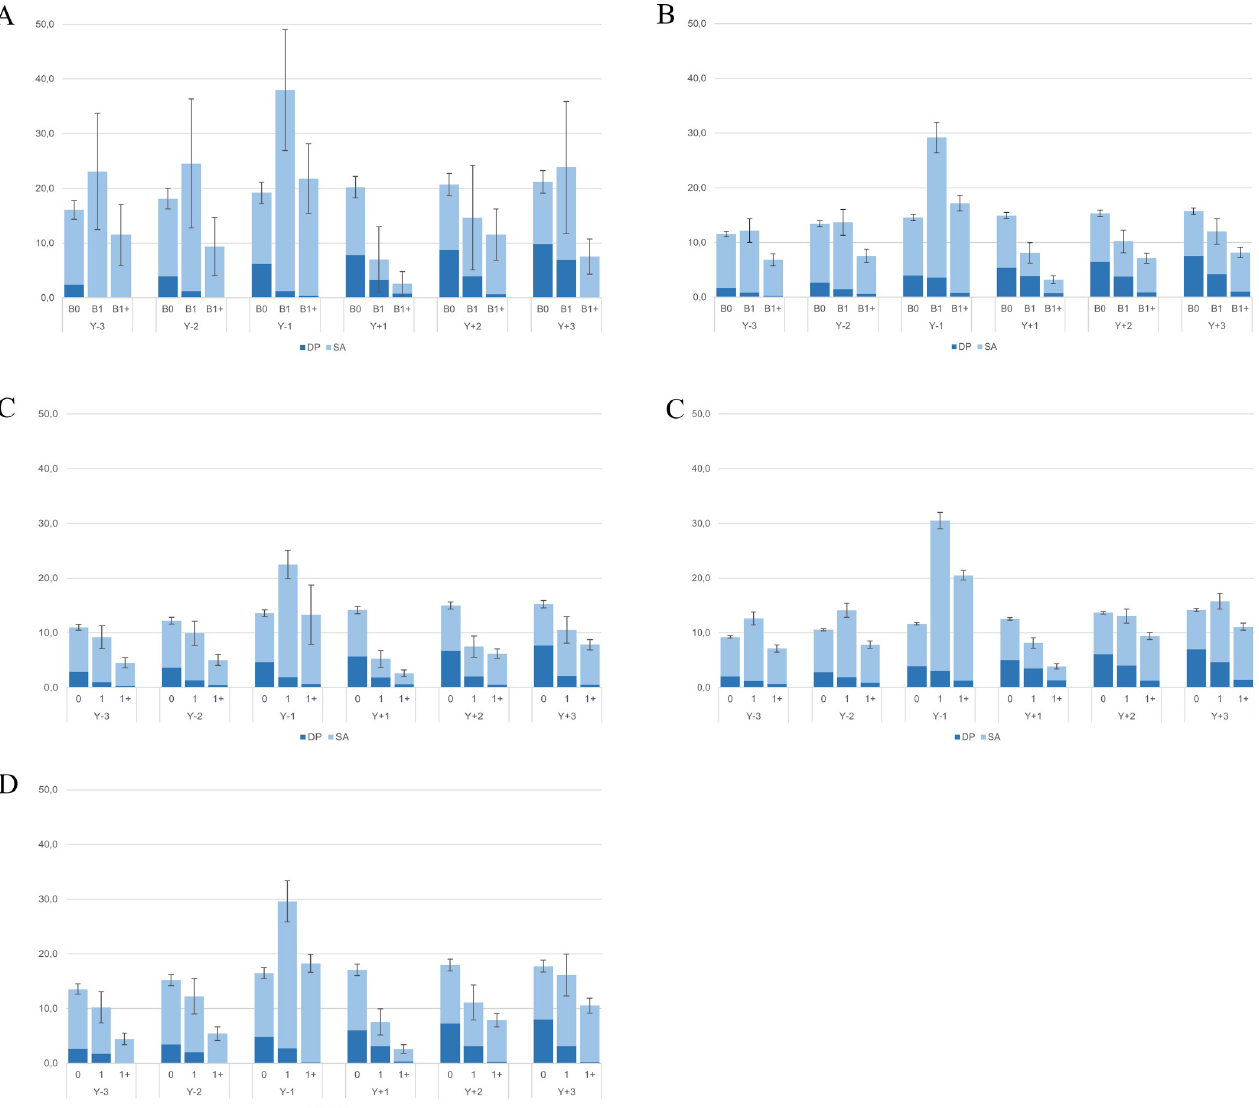
Fig 1. Crude mean sickness absence (SA) and disability pension (DP) net days/year and 95% confidence intervals within the (1a) extremely-male dominated, (1b) male-dominated, (1c) gender integrated, (1d) female-dominated, (1e) extremely female-dominated groups, by childbirth group and study year.